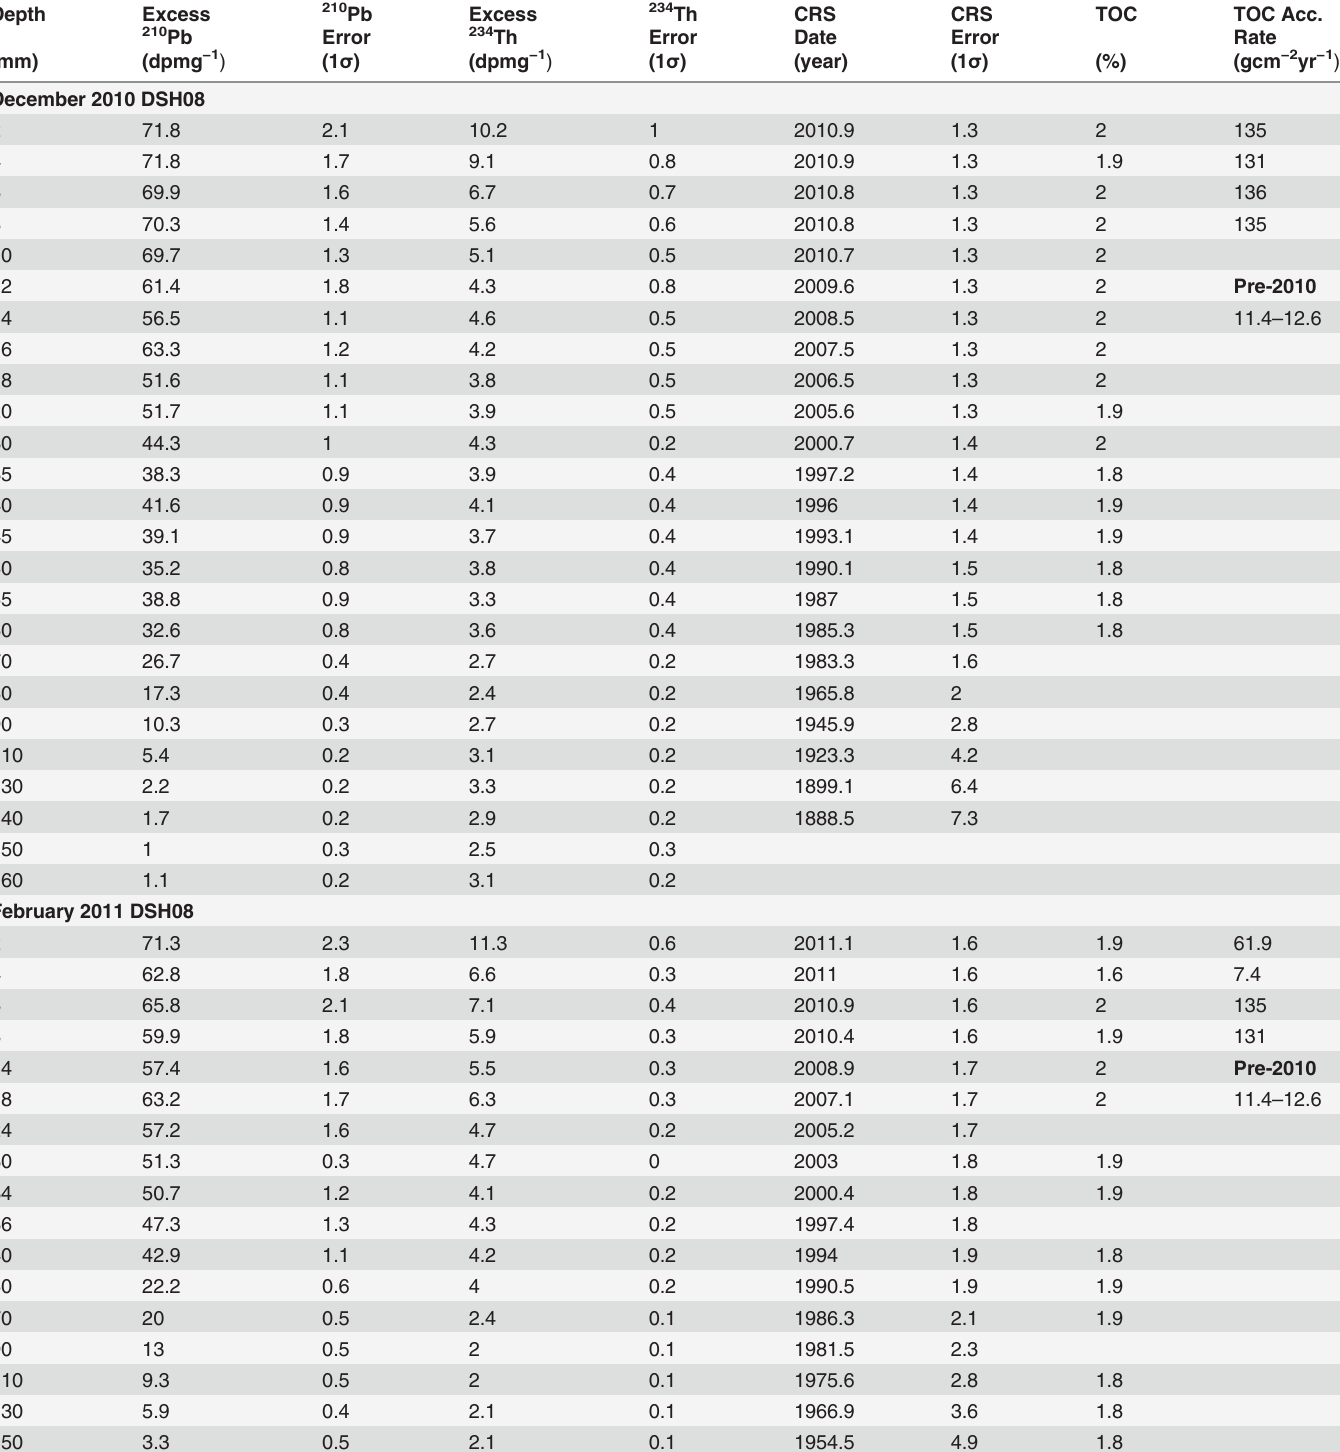
Table 1. Short-lived radioisotope ( 210 Pb, 234 Th) activities, constant rate of supply age model, total organic carbon (TOC) percentages and TOC accumulation rates with depth for each core